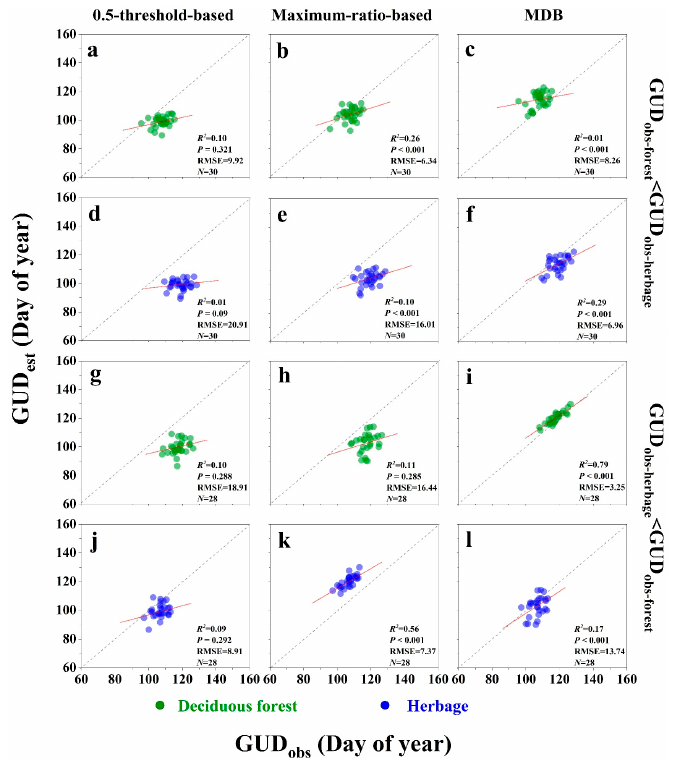
Figure 5. Comparisons between multi-year average observed green-up dates (GUD obs ) of deciduous forest (green) and herbages (blue) and estimated green-up dates (GUD est ) of three methods (0.5-threshold-based method, Maximum-ratio-based method, and Maximum-derivative-based (MDB) method) for forest-herbage-mixed (FHM) sites with GUD obs-forest < GUD obs-herbage ( a – f ) and with GUD obs-herbage < GUD obs-forest ( g – l ). The gray dashed line represents the 1:1 line, and the red lines are the regression lines. The root mean square error (RMSE) was also used to evaluate the predictive